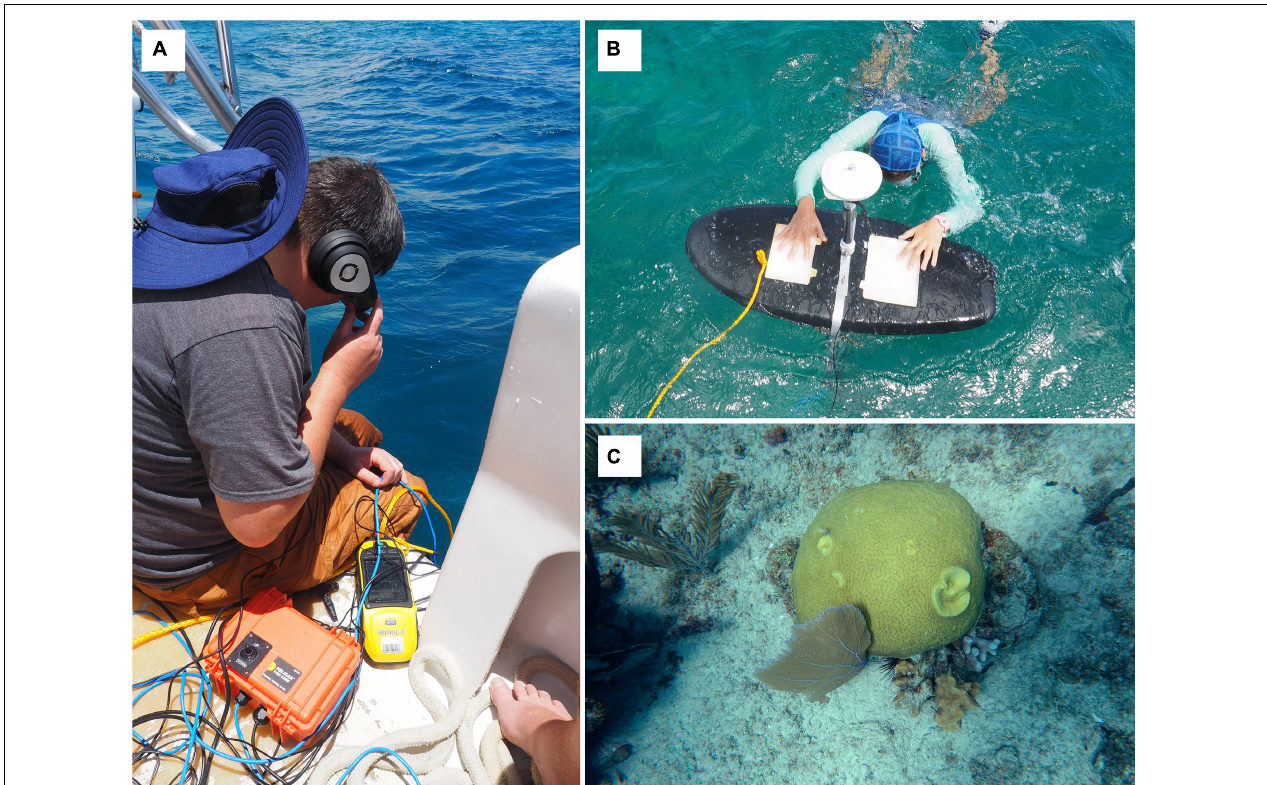
FIGURE 2 | Field data collection used to calibrate the imaging spectrometer benthic classification: (A) an operator on the boat is able to view the video feed from the camera in real-time via HDMI cable; (B) the GNSS receiver antenna mounted to the top of a foam bodyboard and a Sony a6300 camera positioned in a waterproof housing directly below this antenna on the underside of the board to collect vertical photos of the seafloor; (C) an example of one of the 2,477 underwater photos collected with < 1 m positional accuracy that was later classified by proportional cover in the following benthic classes: sand, live coral, algae, seagrass, and rubble.